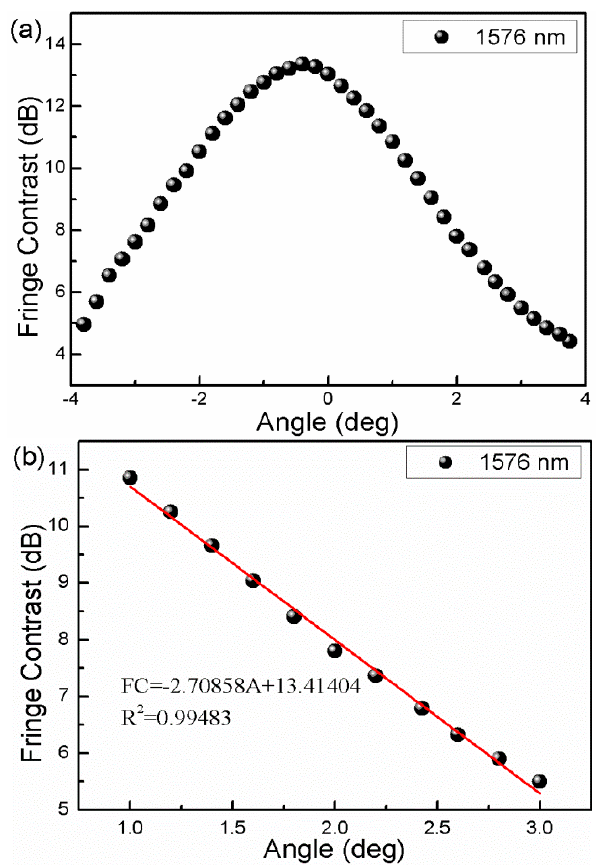
Figure 5. Cont . Figure 5. Cont .